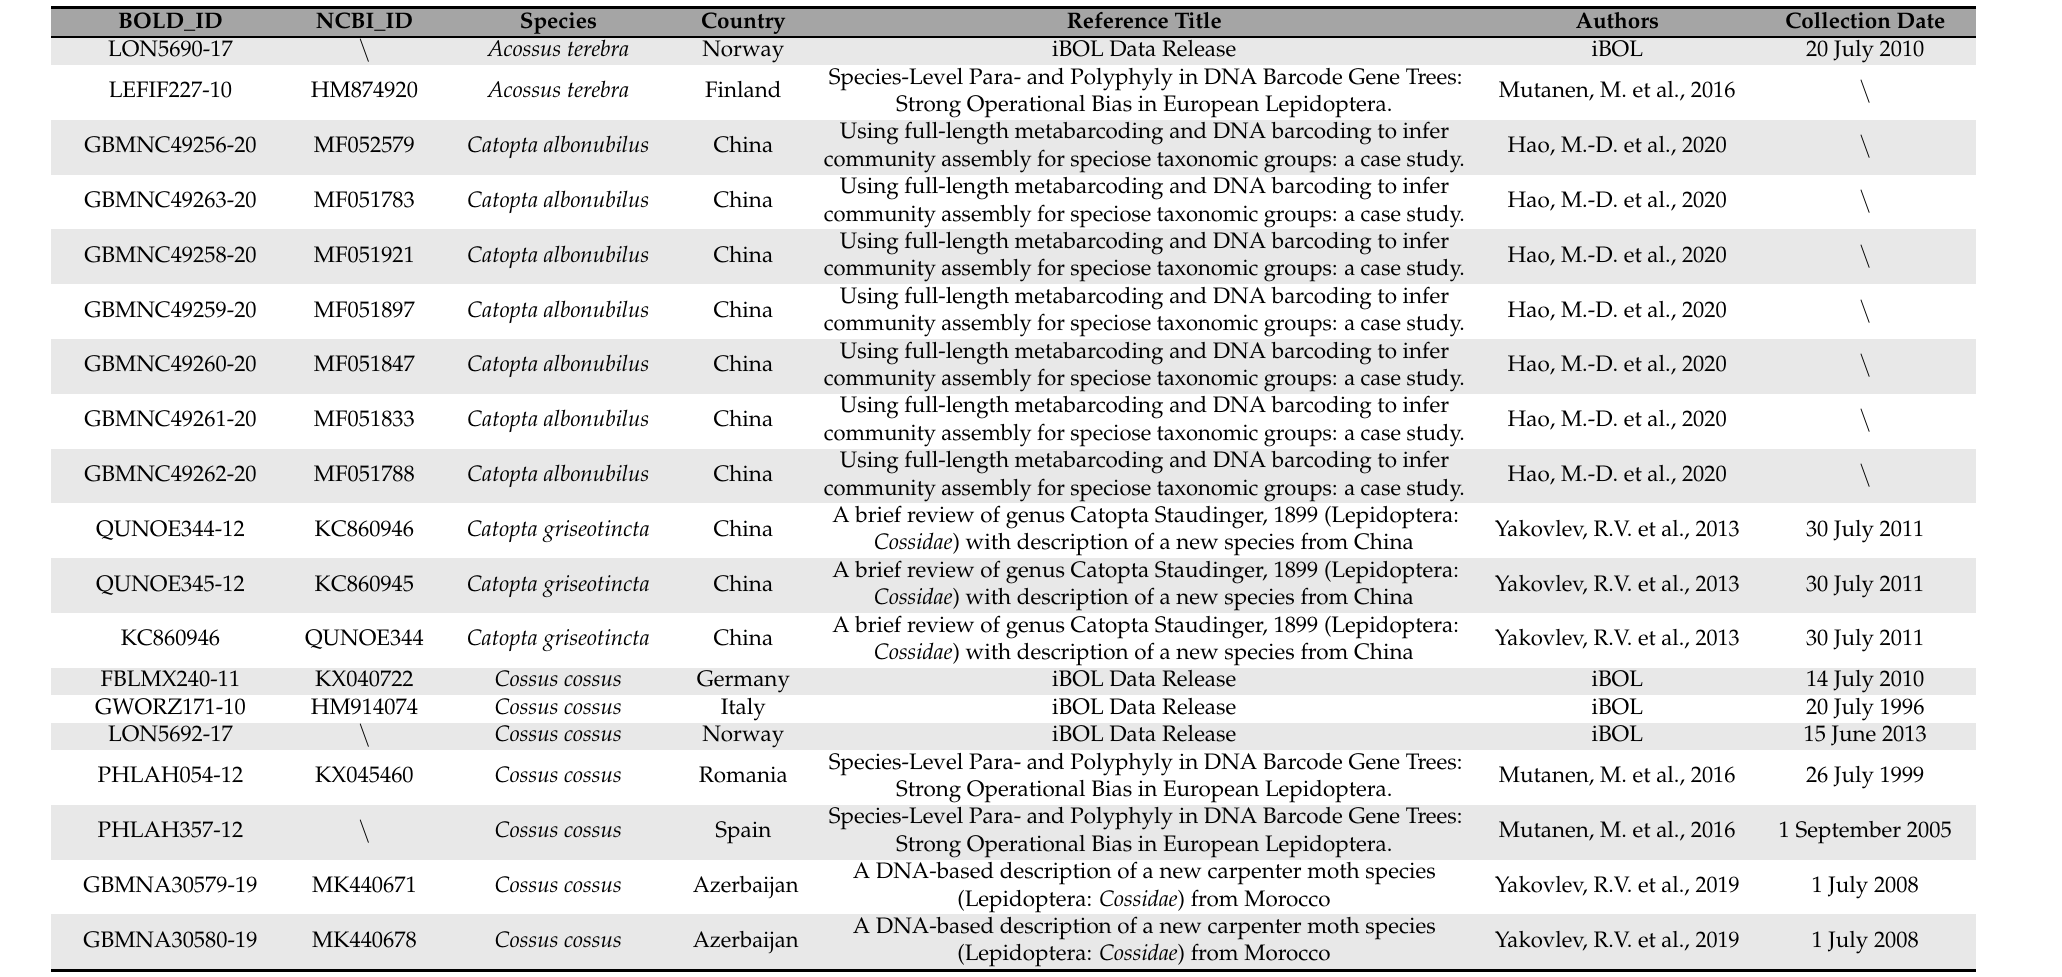
Table A1. The full information for the sequences mined from